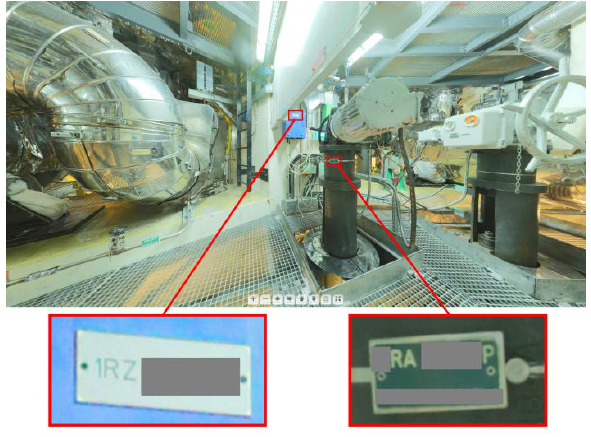
Figure 5: Part of one of the 1025 RGB panoramic image (340 MPxl). Below are shown some details of the panoramic by just zooming in it.